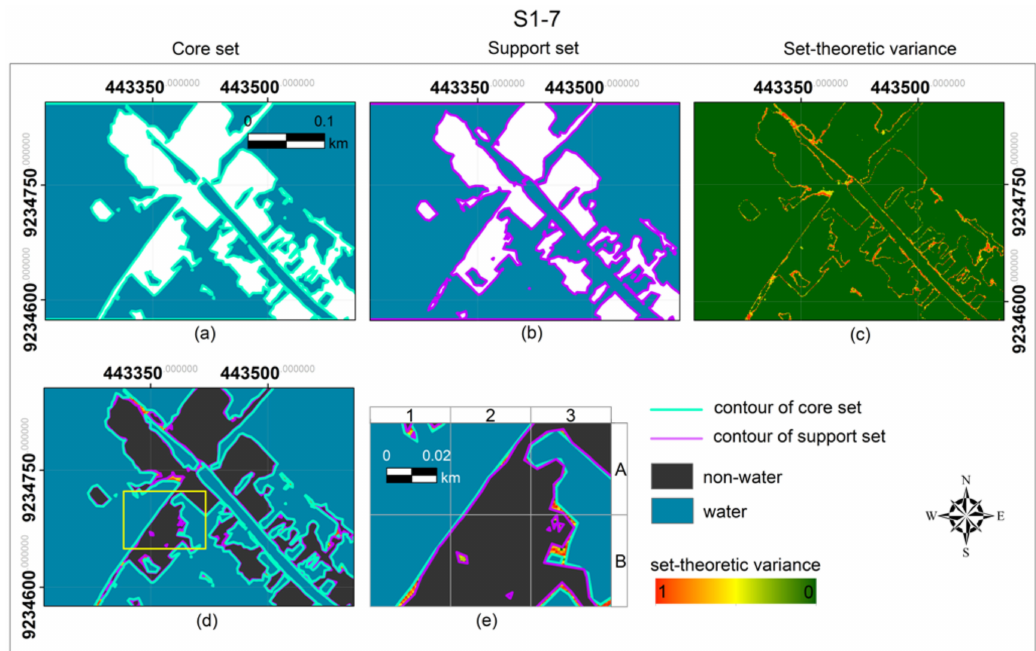
Figure 12. An example of a random set: the core set Γ 1 and its contour ( a ); the support set Γ 0 and its contour ( b ); the set-theoretic variance image ( c ); the transition zone between water and non-water represented by the set-theoretic variance values ( d ); and zoom-in to the yellow rectangle site ( e ).